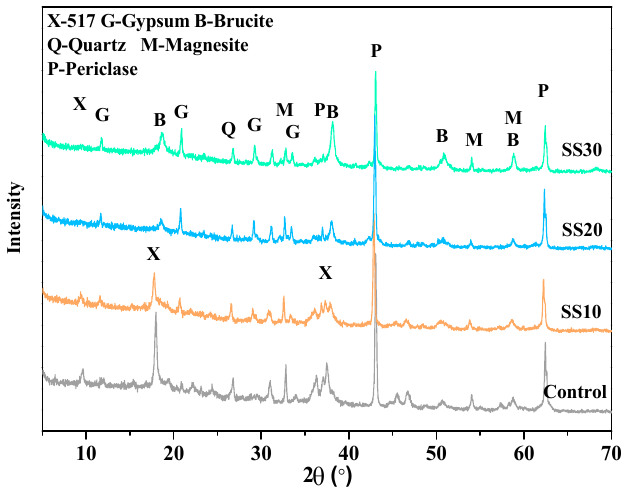
Figure 5. Powder XRD patterns of the control, SS10, SS20, and SS30 with air curing at 28 days.